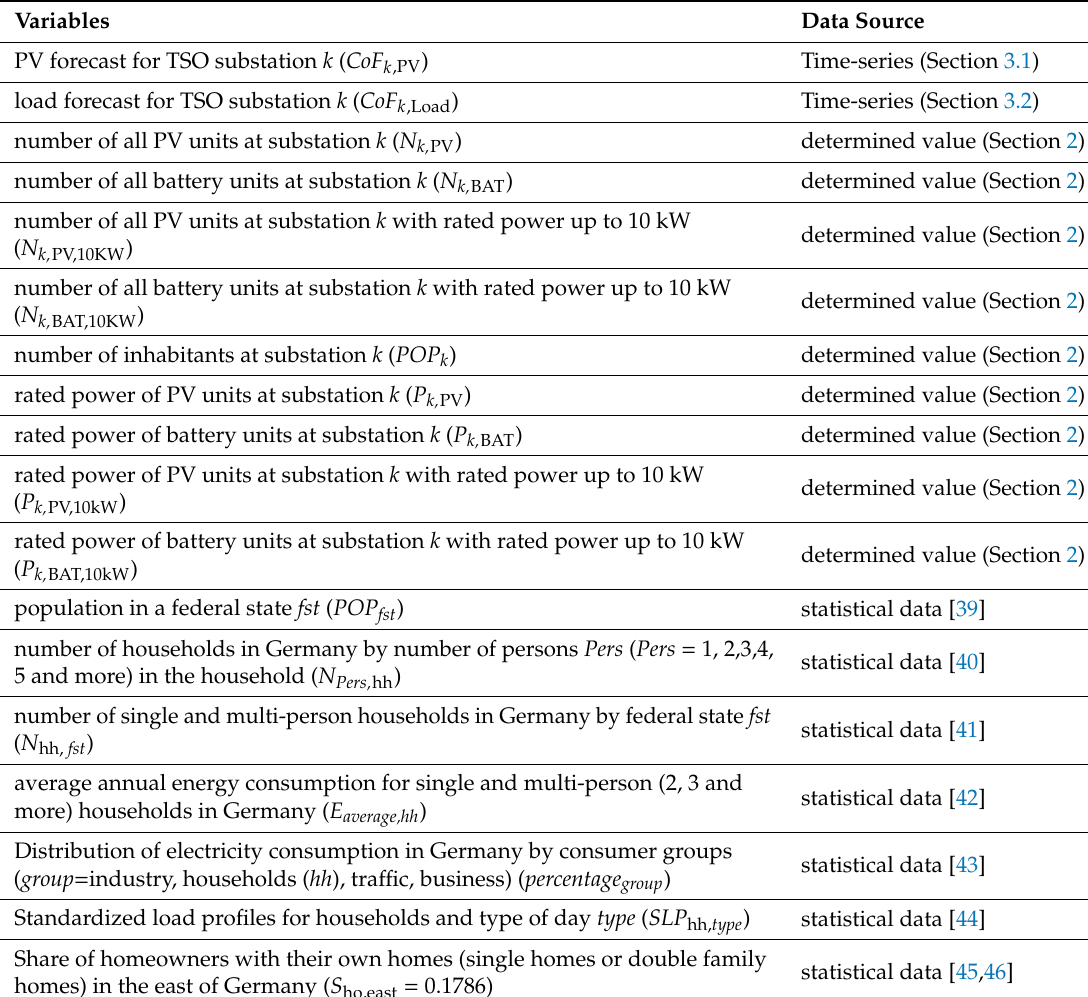
Table 3. Database for the substation-related battery storage